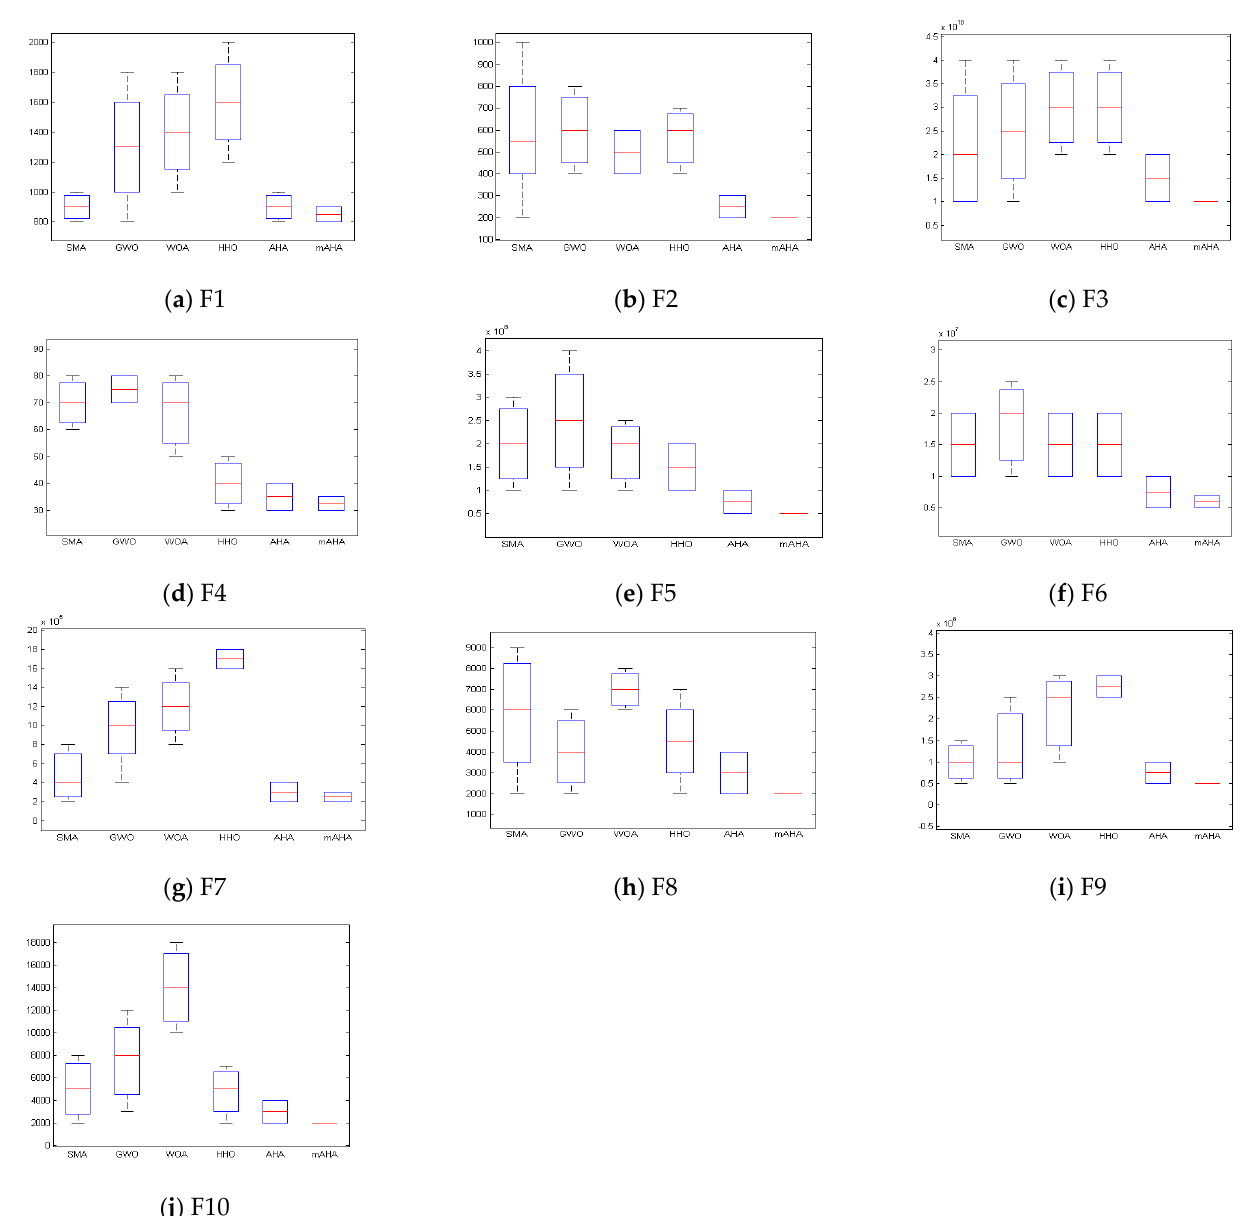
Figure 2. The box-plot curves on the CEC’20 test suite that have been obtained by the proposed mAHA and the competitor algorithms for 30 runs with Dim10.